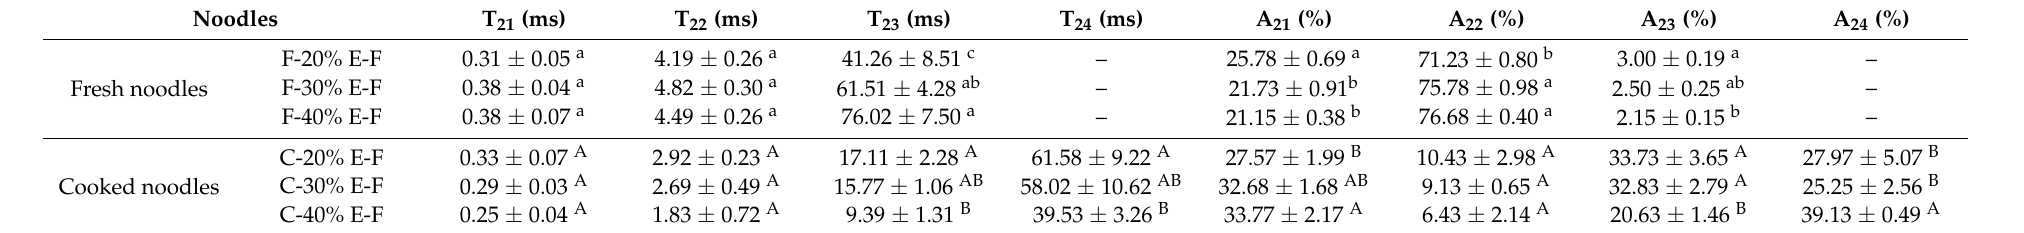
Table 2. The relaxation times, T2, and peak areas, A2, of gluten-free